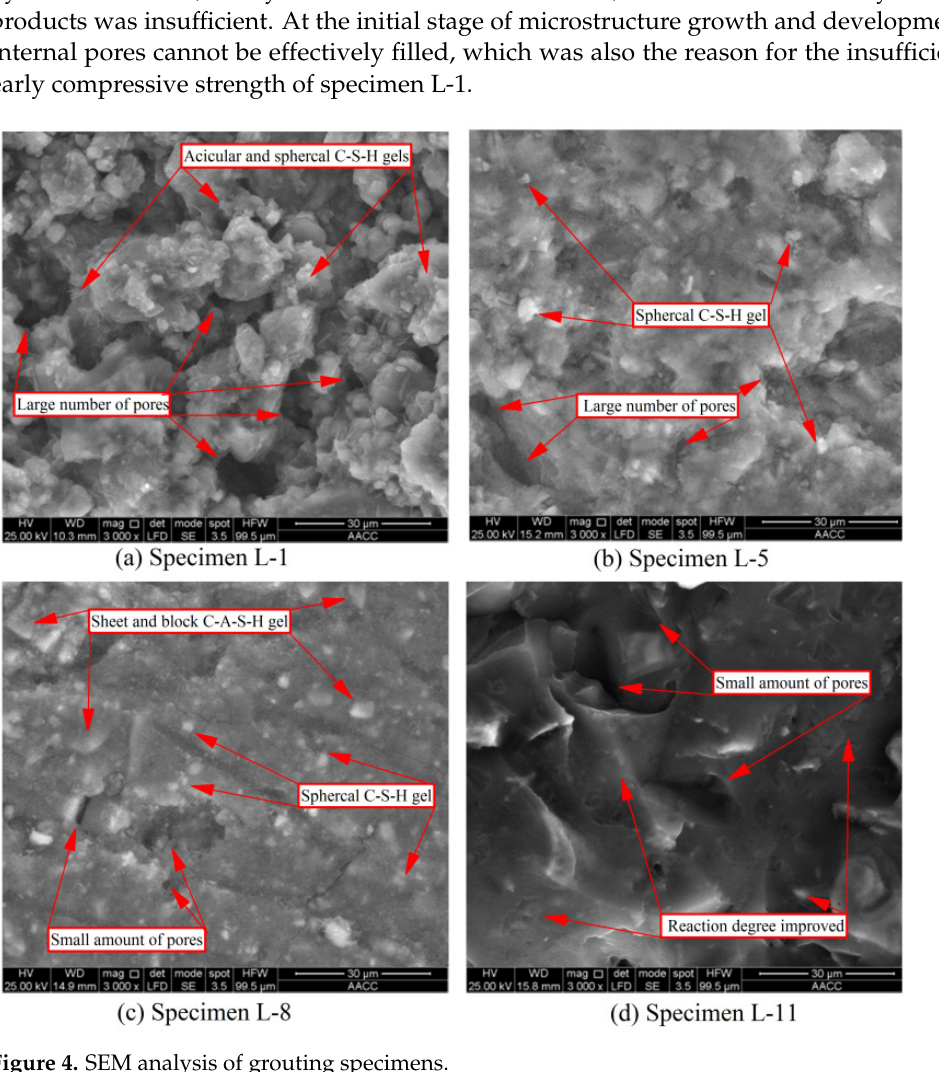
Figure 4. SEM analysis of grouting specimens.